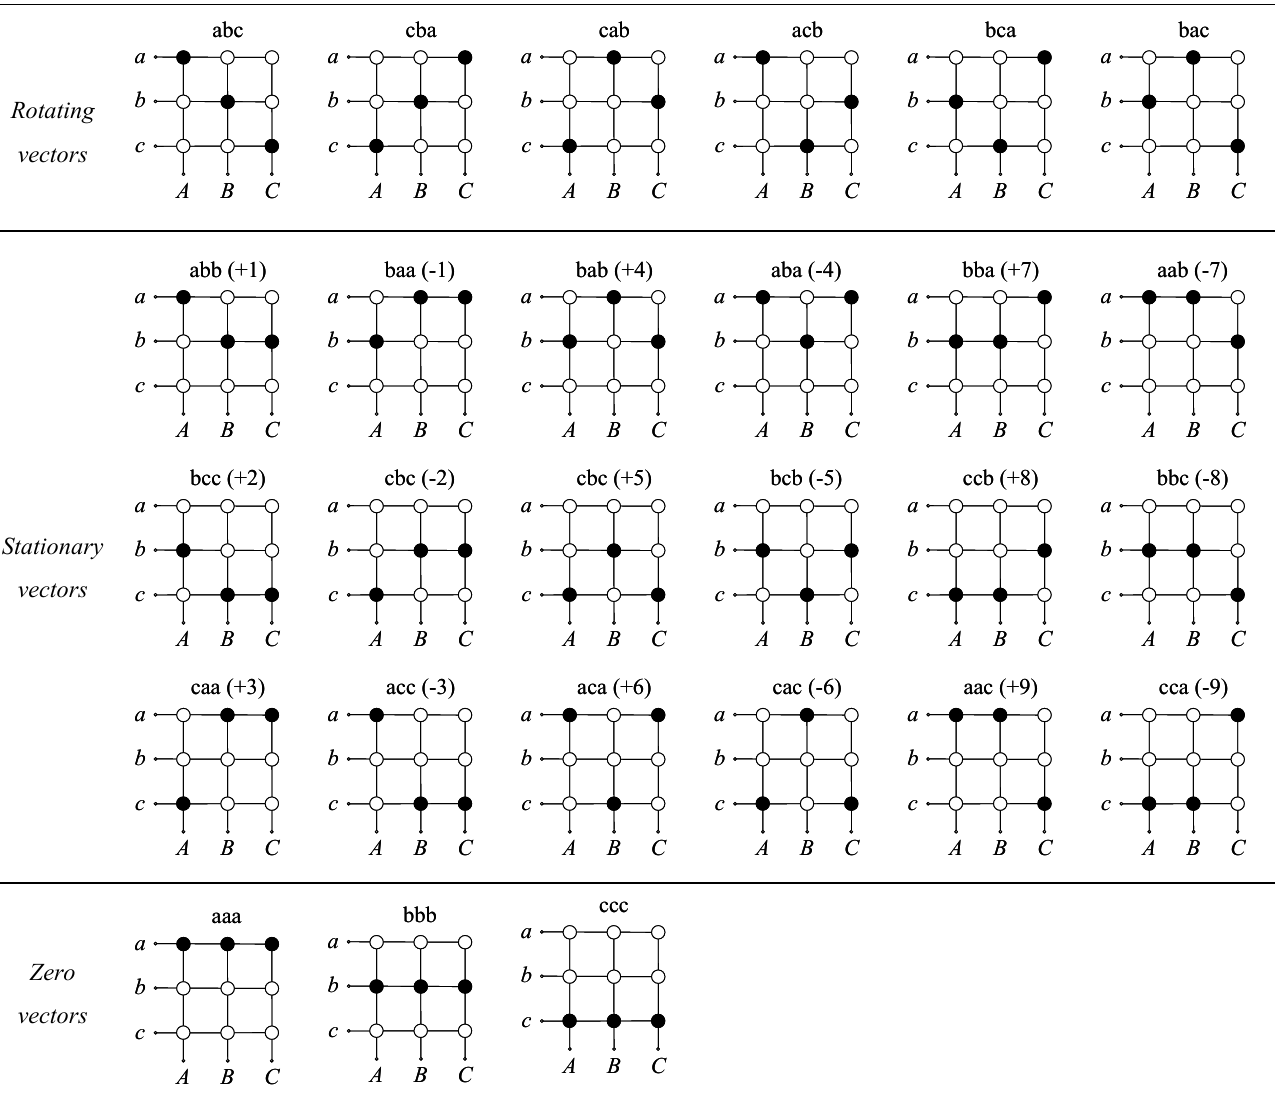
Figure 4. The 27 allowed switch states in a matrix